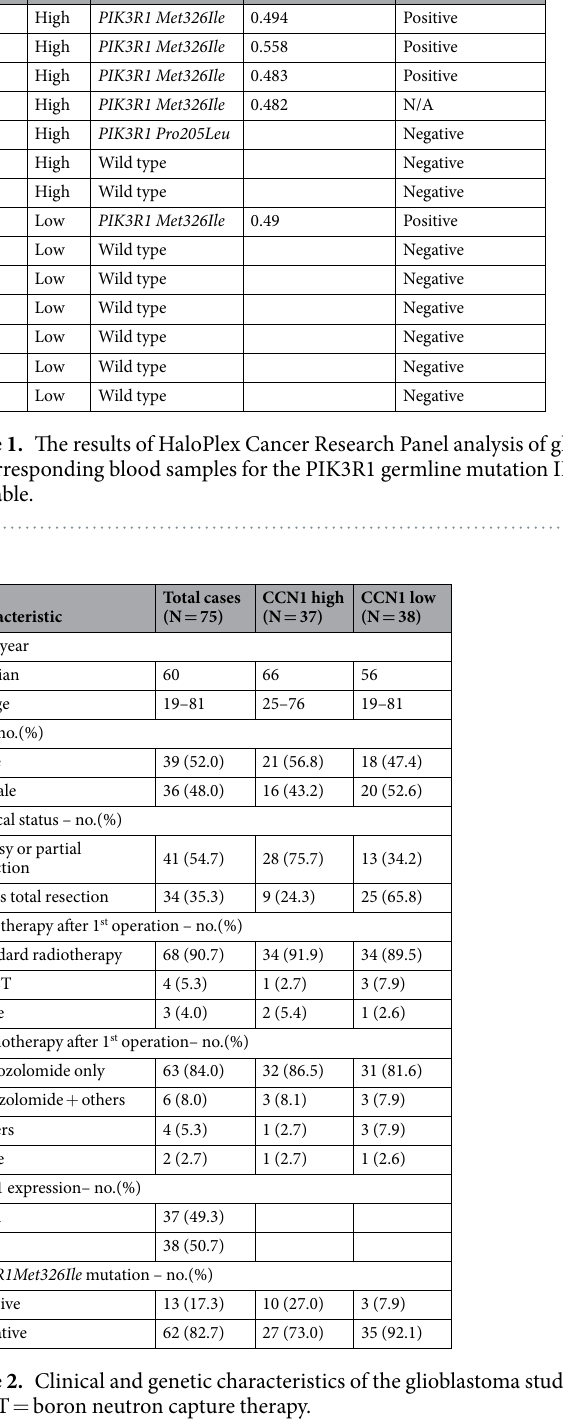
Glioblastoma patients with PIK3R1Met326Ile had poor PFS and OS. To investigate the relationship between clinical characteristics and prognosis, PFS and OS curves relative to PIK3R1Met326Ile mutations were obtained using the Kaplan-Meier method. The survival curves were compared using a log-rank test based on age, sex, surgical status, CCN1 expression and PIK3R1 mutational status. The results showed that gross total resec- tion, high CCN1 expression and PIK3R1Met326Ile (Fig. 4A) were significantly associated with PFS ( p = 0.0138,